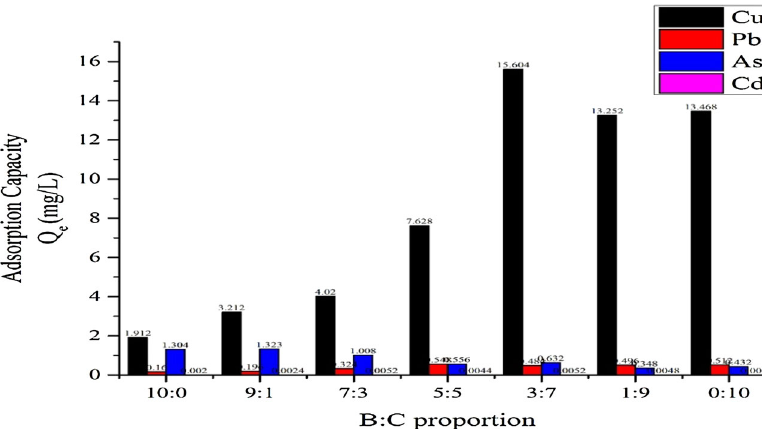
Fig. 4 Adsorption Capacity of B:C membranes for industrial wastewater